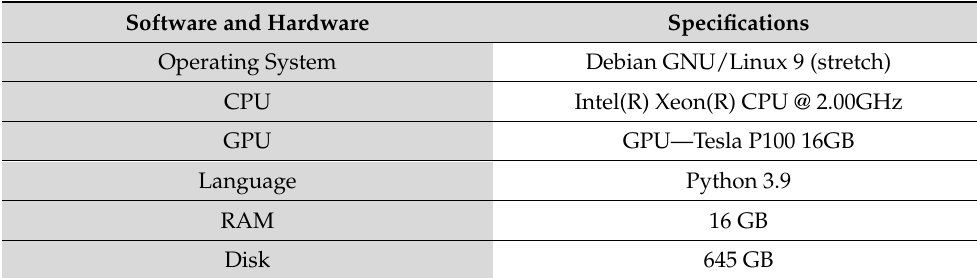
Table 1. Computer resources.